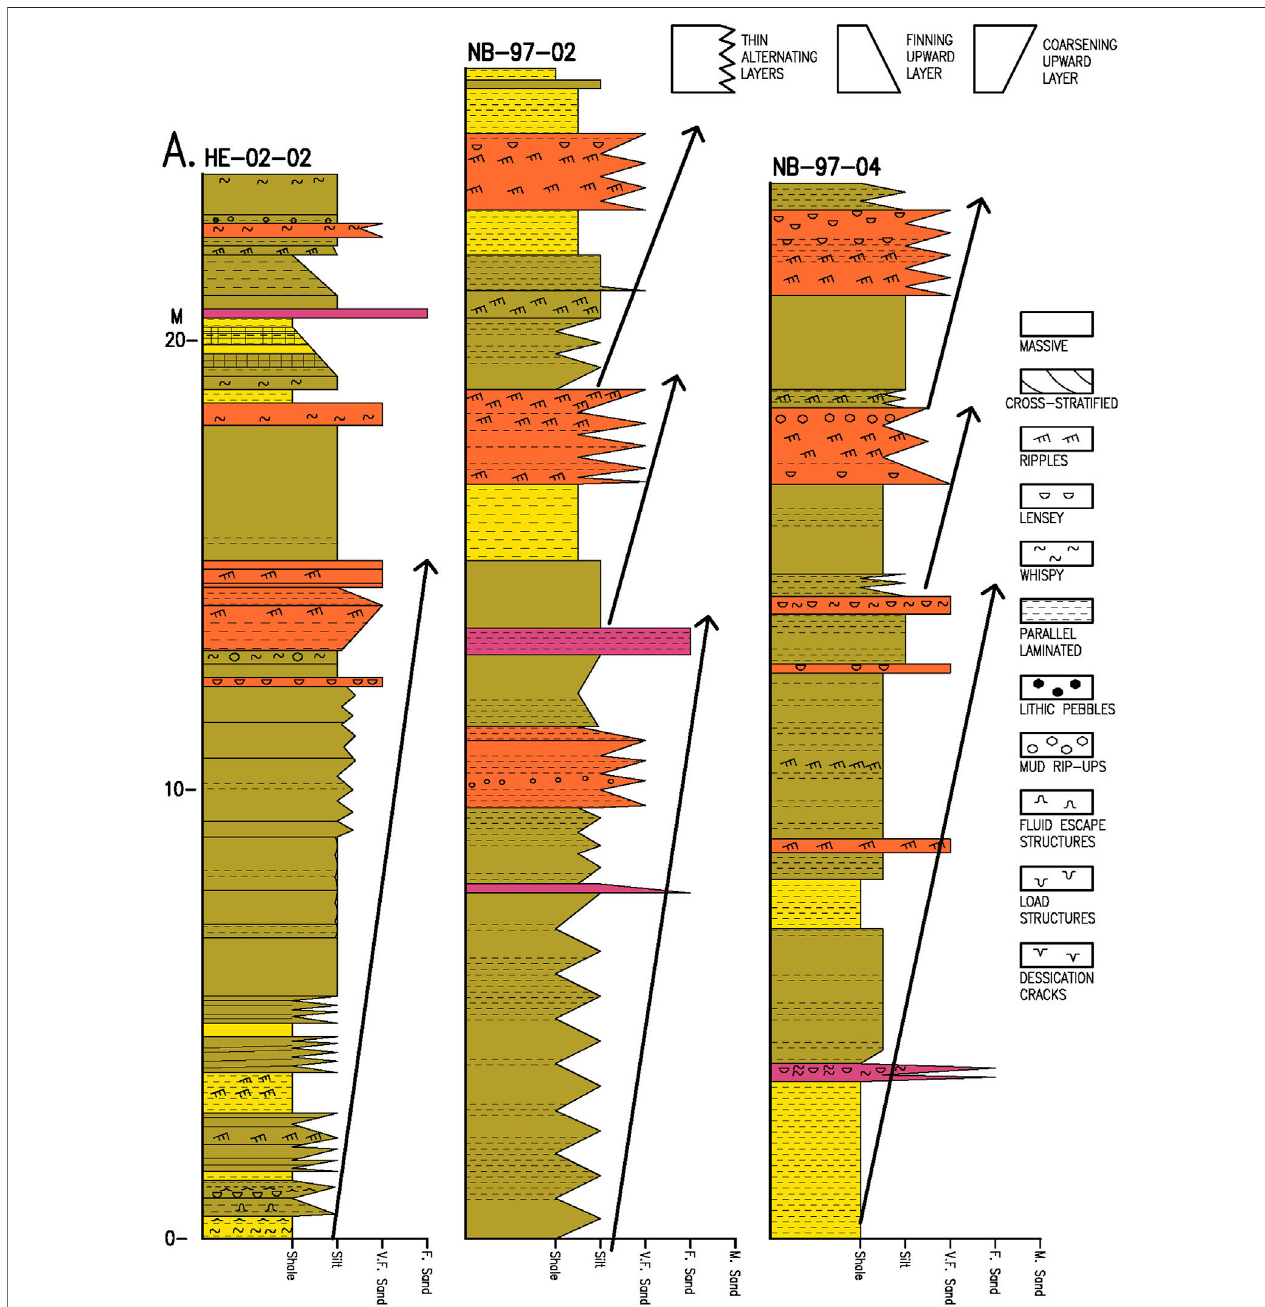
FIGURE 3 | Detail of parasequences in the basal portion of the lower coarsening- and thickening-upward succession. The three parasequences in NB-97-02 are relatively aggradational, whereas the same three parasequences in NB-97-04 are progradational. This highlights that the aspect of parasequence sequencing can vary due to position of the depositional site relative to the sediment entry point, which controls development of accommodation space. The lowermost parasequence is coarsest in drill-hole 02 indicating a position closest to the sediment entry point into the subaqueous delta. The upper two parasequences are coarsest in section 04, likely caused by movement of the distributary mouth closer to this area. This positioning would result in shallower water where these two parasequences were deposited and thus they were more likely to prograde. Location of detailed sections in A depicted on Figure 2 . Lensey refers to lensoid layering, which is equivalent to indistinct lenticular bedding. Wispy layering consists of contorted, thin layer fragments.